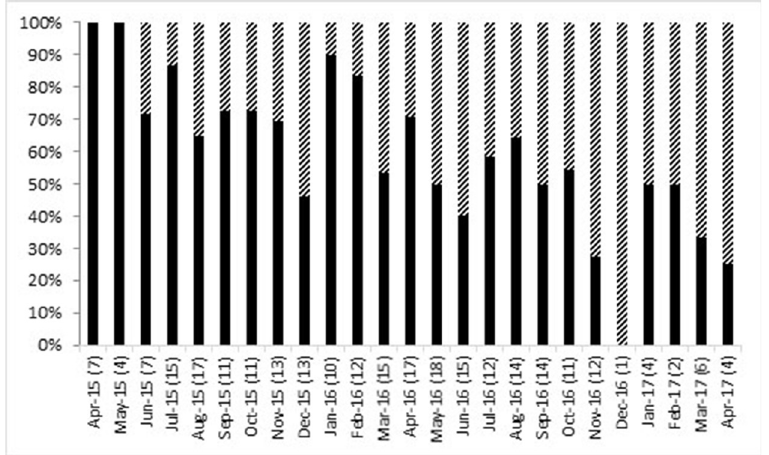
Figure 4. Monthly percentage of individuals of Homonota taragui marked (black bars) and recaptured (striped bars) in Paraje Tres Cerros during April 2015 and April 2017